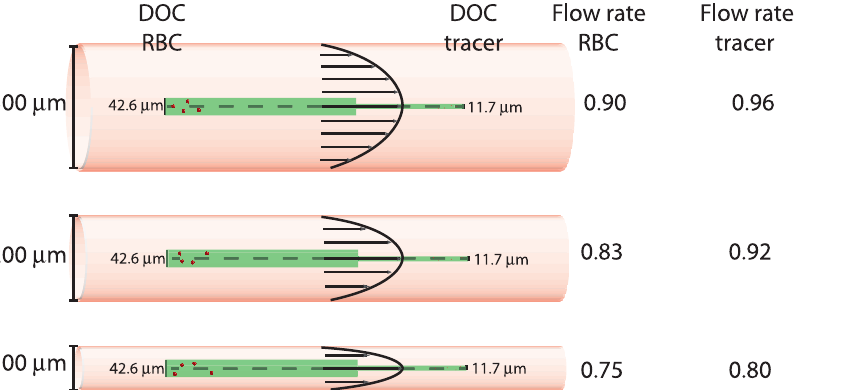
Figure 9. Example of predicted underestimation for various diameters. Schematic representation of depth-of-correlation and resulting flow rate underestimation a for red blood cells (RBC) and artificial tracers for measurements in geometries of 300, 200 and 100 m m . Model predictions for M =25 | .